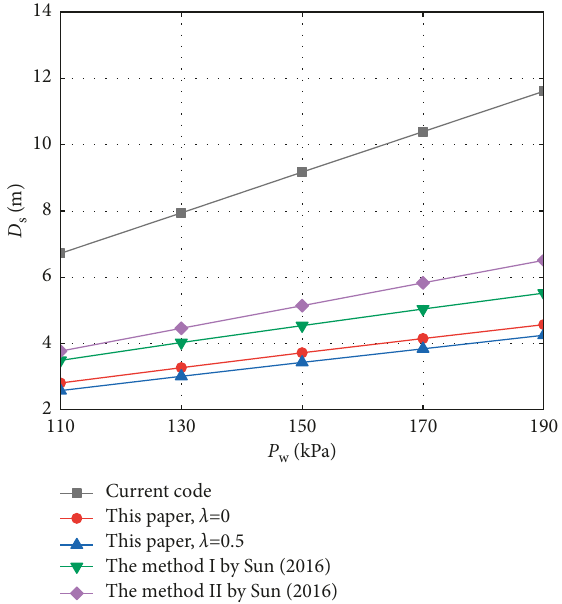
Figure 7: Critical safety thickness of the base corresponding to B × L � 12m ×